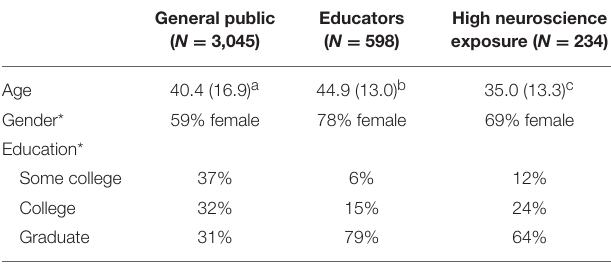
TABLE 1 | Demographics.